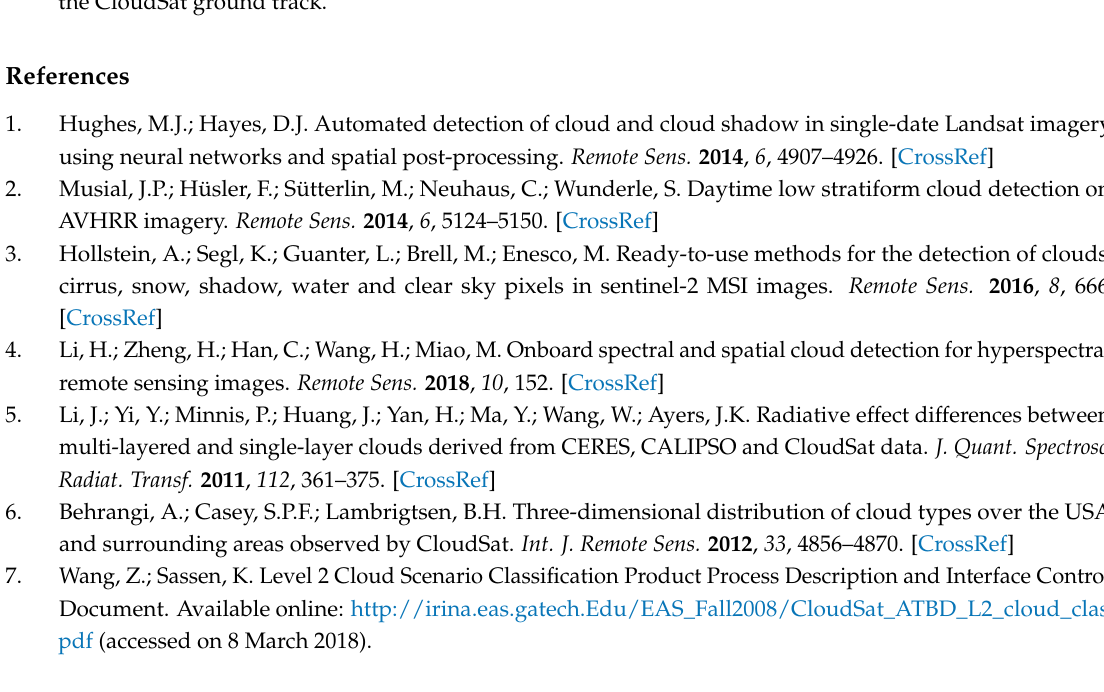
Figure A4. CloudSat orbital characteristics curves with latitude. ( a ) 0.5(𝑑𝐿 𝑀 + 𝑑𝐿 𝑃 ) , ( b ) √𝑑𝐿 𝑀2 + 𝑑𝐿 𝑃2 , and ( c ) √𝑑𝐿 𝑀2 + 𝑑𝐿 𝑃2 𝜑⁄ with 95% latitude and longitude differences of the nearest two pixels along the CloudSat ground track.